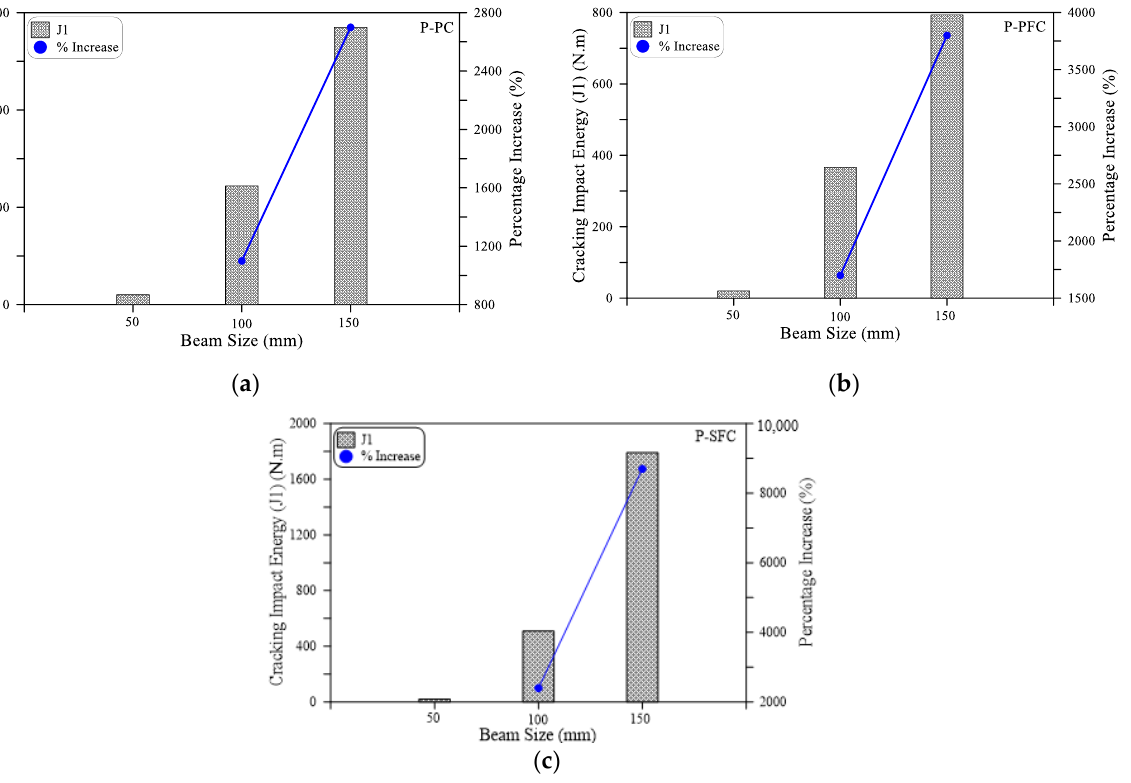
Figure 10. Cracking impact energy (J1) of the three beam sizes: ( a ) PC; ( b ) P-PFC; ( c ) P-SFC.